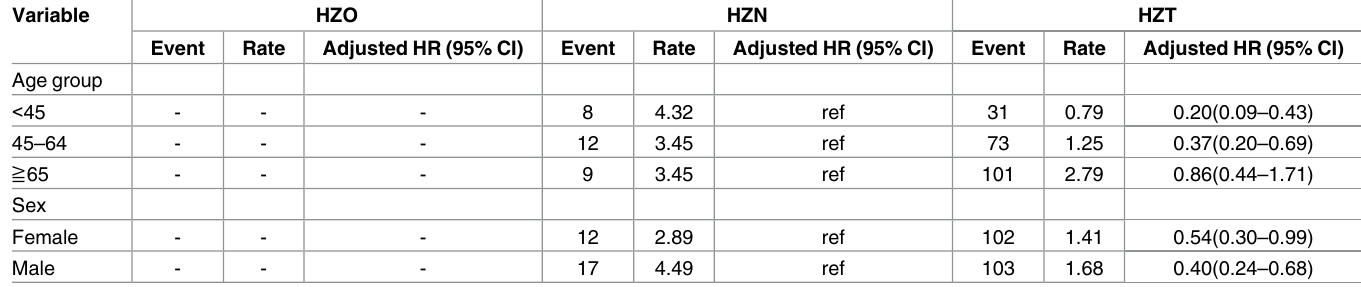
Table 4. Risk of herpes zoster complications (ocular) in different types of herpes zoster stratified by age and sex. Adjusted HR: Adjusted for age, sex, CAD, hypertension, hyperlipidemia, DM, stroke, AF, renal disease, heart failure, cancer, chronic hepatitis, and SLE. Rate: incidencerate per 1000 per- son-years.